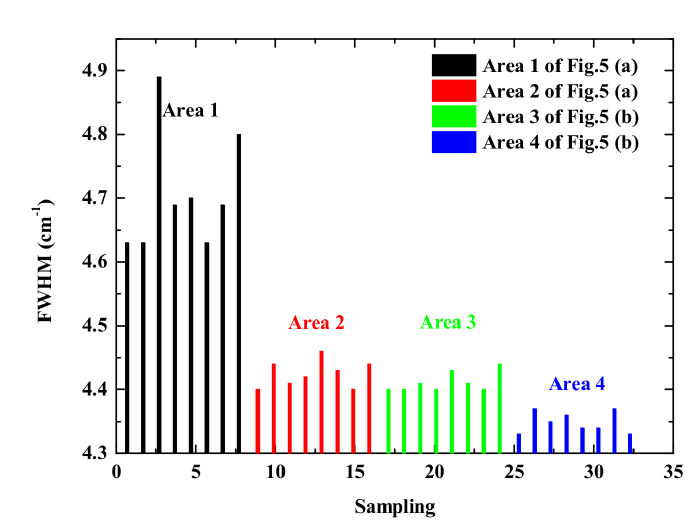
Figure 7. Full width at half maximum values (FWHMs) of the diamond Raman lines obtained from the different areas indicated in Figure